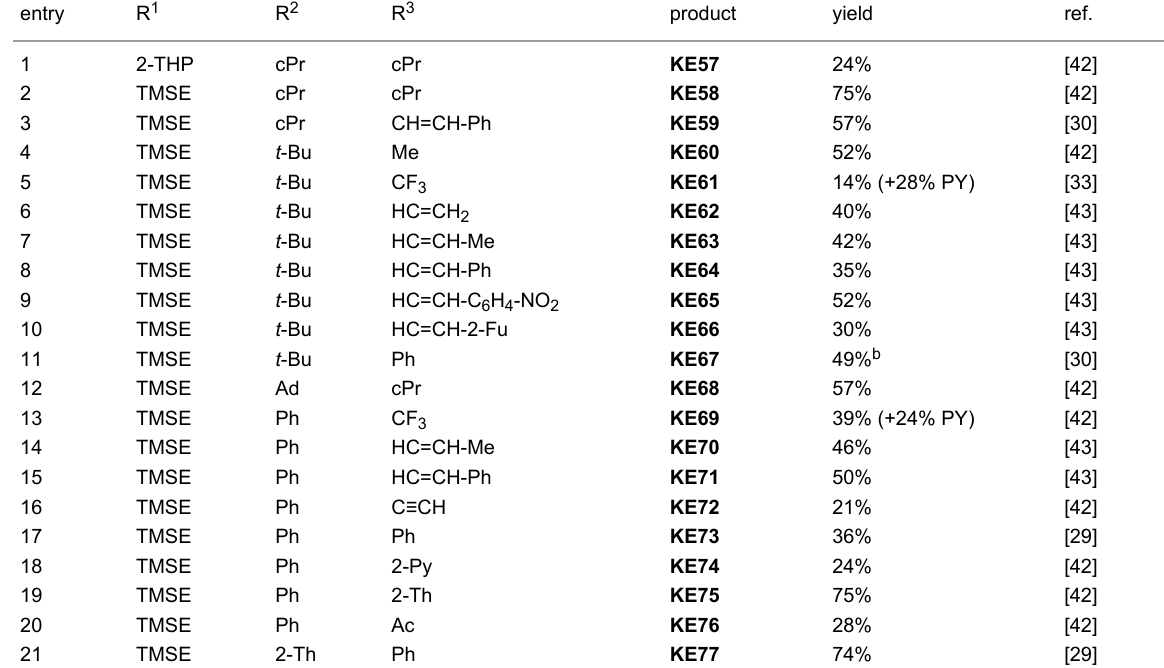
Table 3: Synthesis of β -ketoenamides KE57 – 77 by the LANCA three-component reaction of lithiated 2-(trimethylsilyl)ethoxyallene, nitriles (R 2 -CN) and carboxylic acids (R 3 -CO 2 H) according to Scheme 4.